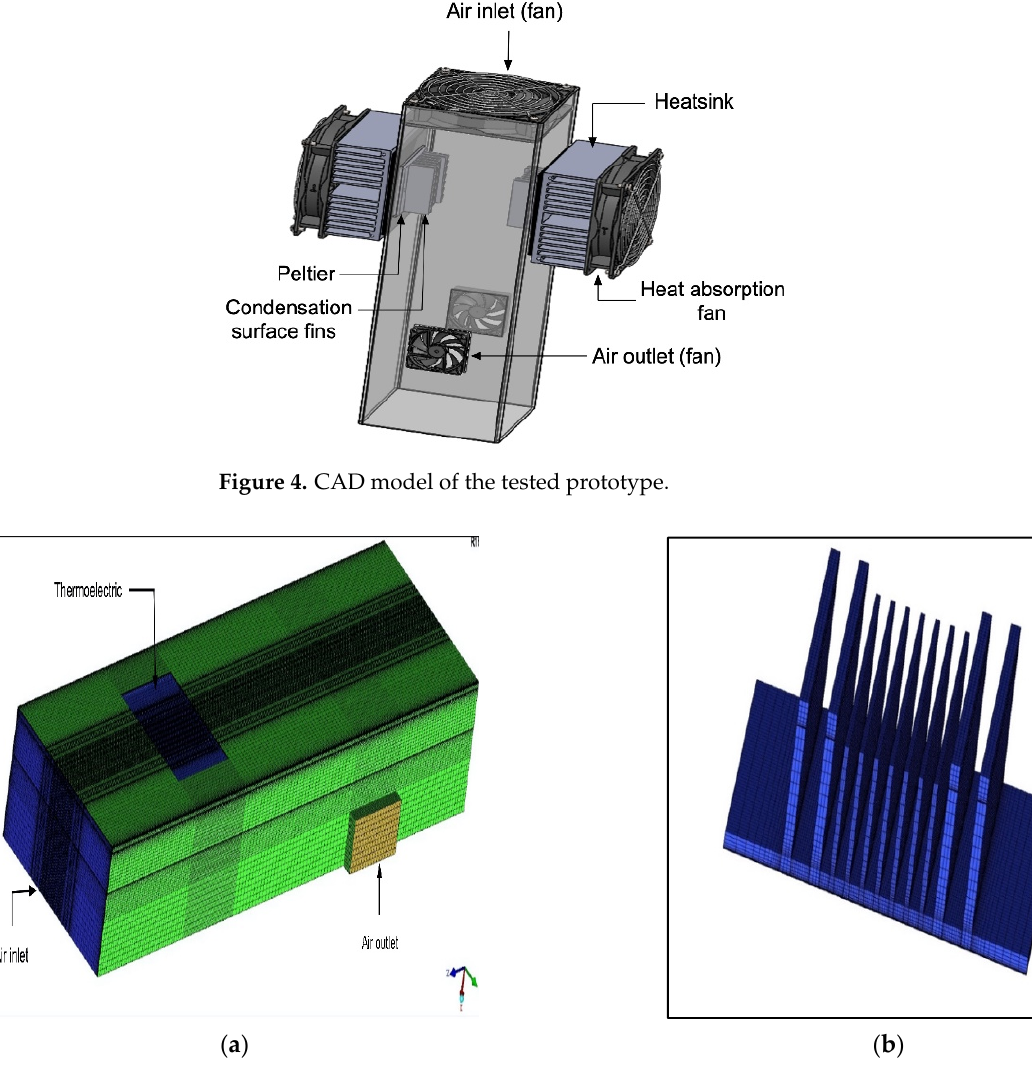
Figure 5. ( a ) ICEM mesh of the proposed model; ( b ) meshing of the cooling surface. Table 2. Boundary conditions.